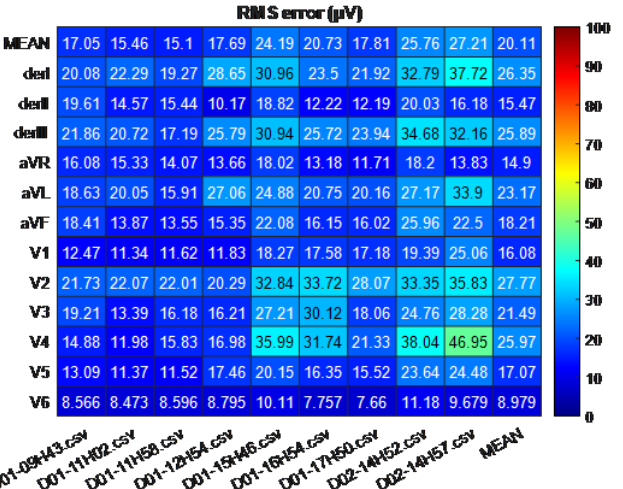
Figure 10. Results for one of the FoMs (the RMS error) where the reconstruction is evaluated over several days at different time instants. To carry out this reconstruction, the algorithm (ANN for each lead) was only trained with the first 16 s of the first record, and the model performed the reconstruction of the rest of the records, without any feedback. The x-axis shows the records, identified with the day D and the time xxHxx at which they were taken, and the y-axis shows the standard leads, as well as their mean RMS Error value for each